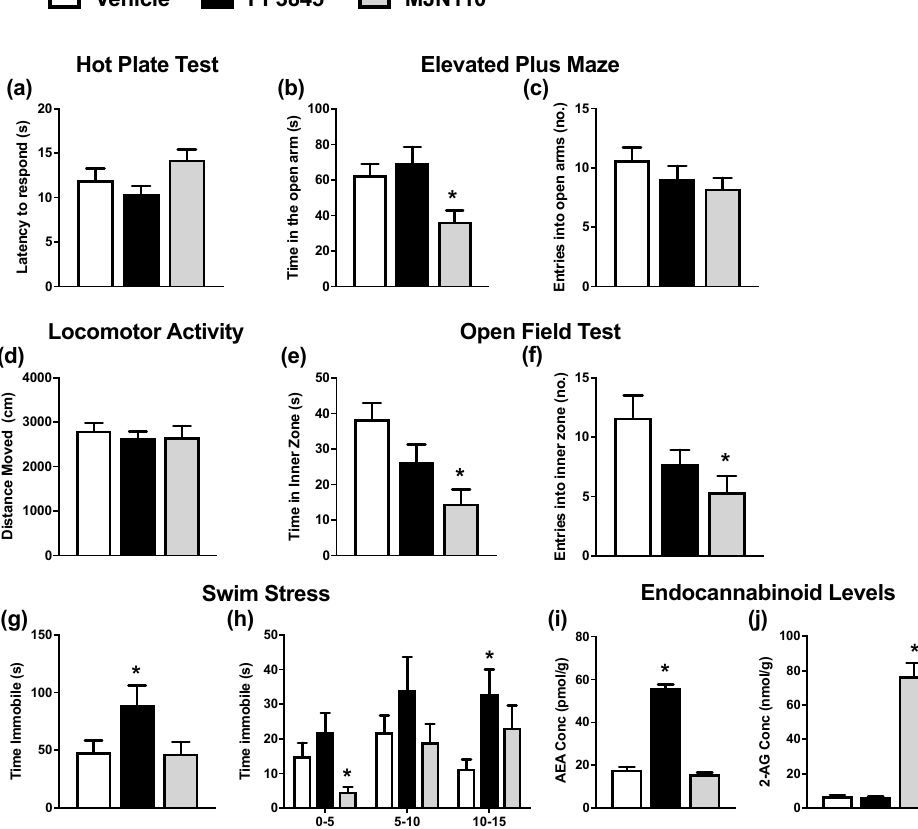
Figure 3. The effect of PF3845 (10 mg/kg) and MJN110 (5 mg/kg) on nociceptive and affective behaviour and endocannabinoid levels in VPA-exposed female rats during adolescence. ( a ) Latency to respond in the HPT. ( b ) Time in open arms and ( c ) number of entries into the open arms during the EPM. ( d ) Locomotor activity, ( e ) time in inner zone and ( f ) number of entries into the inner zone during the OFT. ( g ) Time spent immobile during the 15-min FST and ( h ) over-5-min time bins. ( i ) AEA and ( j ) 2-AG levels in the cortex. Data expressed as mean + SEM (n = 11 to 12 per group). * p < 0.05 vs. vehicle. Analysis of time spent in the open arms of the EPM revealed a significant drug treatment effect (F (2,33) = 5.73, p = 0.007). Post hoc testing demonstrated that MJN110, but not PF3845, reduced the time spent in the open arms (Figure 3b). MJN110 or PF3845 did not alter the number of entries into the open arms (Figure 3c). In the OFT, locomotor entries into the inner zone revealed significant drug treatment effects [time: (F (2,32) = 6.74, p = 0.004); frequency: (F (2,32) = 4.39, p = 0.021)]. Further post hoc analysis revealed